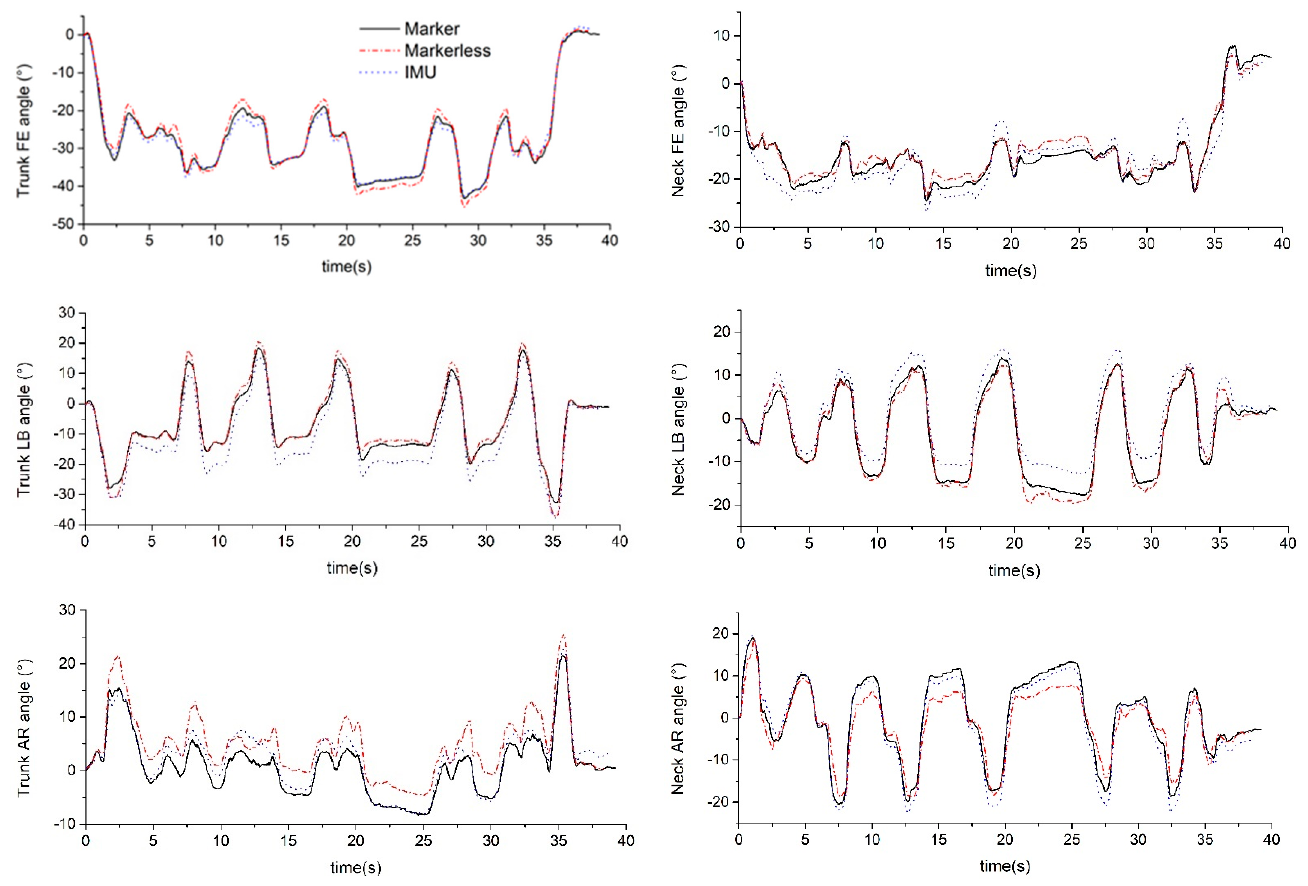
Figure 6. Exemplar simulated surgery task. Table 2. RMSE (mean ± SD), Range of motion difference (mean ± SD, in degrees), Limits of agreement and Relative ROM error between the IMU/Markerless method and the gold standard. Trunk FE Trunk LB Trunk AR Neck FE